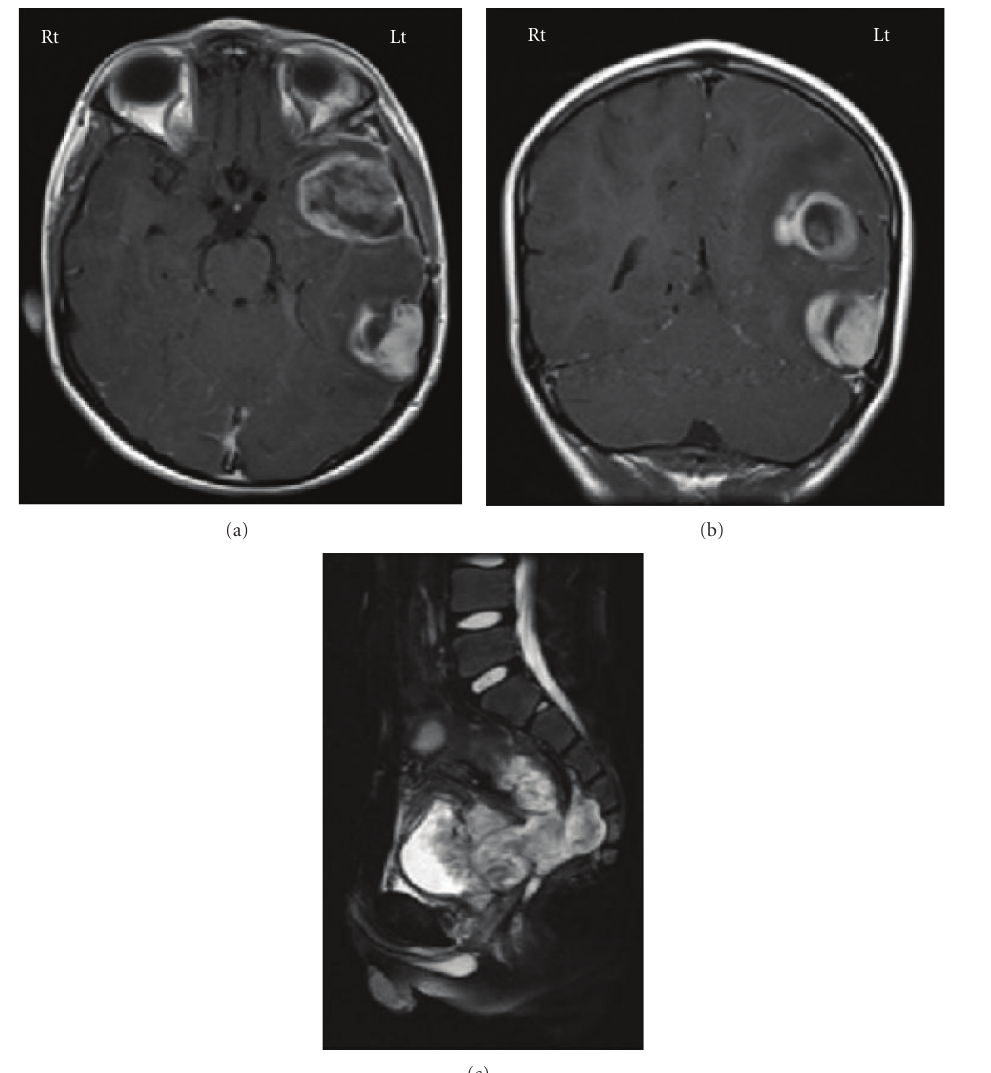
Figure 3: MRI brain shows the dissemination of the GBM in the left hemisphere ((a) (b)). (c) MRI pelvis (sagittal) demonstrates extensive colorectal adenocarcinoma